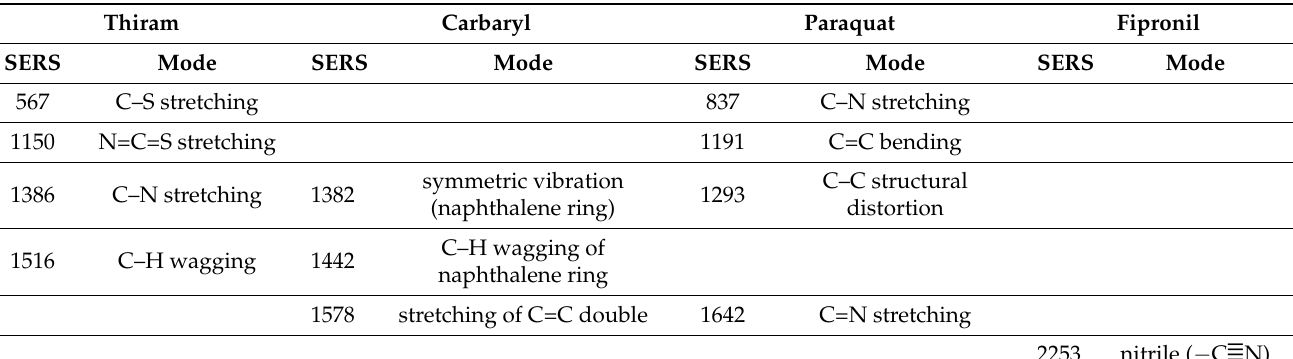
Table 1. Assignments of the Raman modes in pesticides, taken from references as indicated in manuscript. SERS unit (cm − 1 ). Thiram